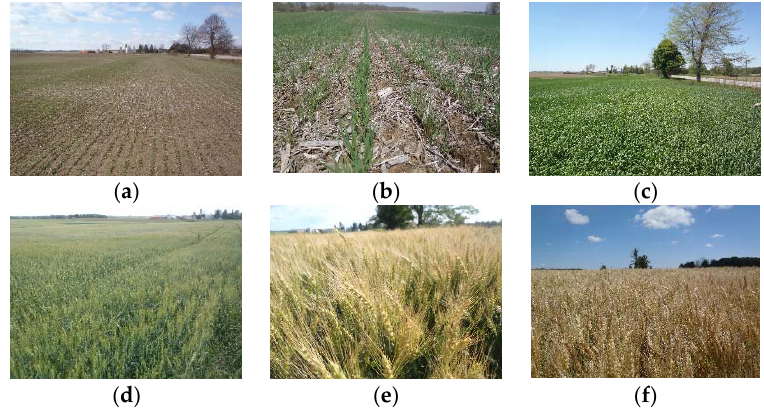
Figure 8. The ground truth photos of wheat. ( a ) April 11, ( b ) May 6, ( c ) May 23, ( d ) June 19, ( e ) July 2 and ( f ) July 16.